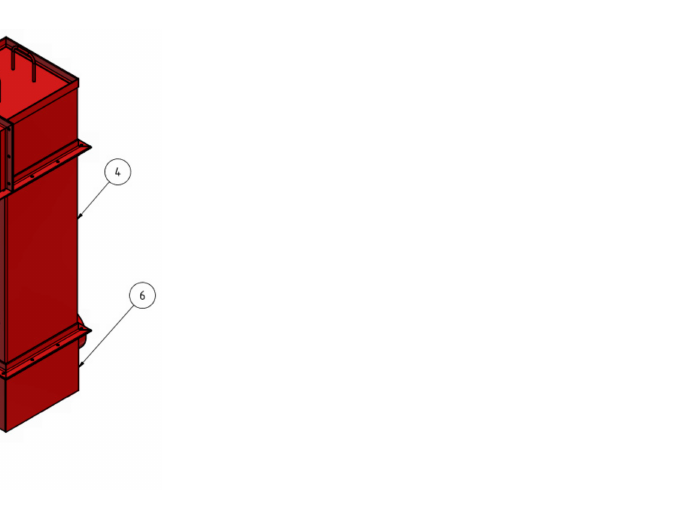
Figure 8. Final design of boiler. 1, burner; 2, combustion chamber; 3, primary heat exchanger; 4, secondary heat exchanger; 5, top chamber.